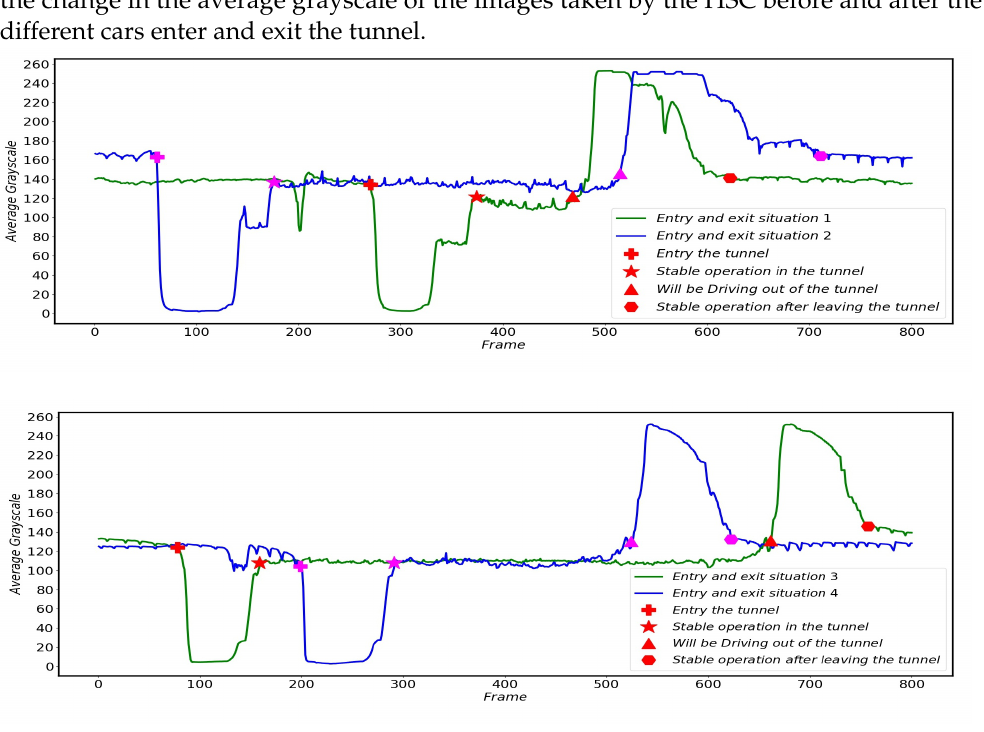
Figure 15. Average grayscale variation of images of HSR-A ( top ) and HSR-B ( bottom ) when driving into different